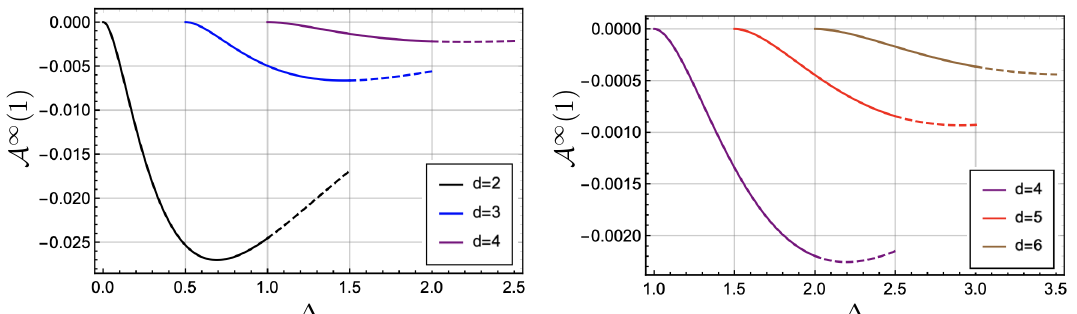
Figure 3. A ∞ ( U 0 ) = R ∞ T UU dU versus ∆ for increasing values of d . On the left panel we have d = U 0 2 (black curve), d = 3 (blue curve), d = 4 (purple curve). On the right panel we have d = 4 (purple curve), d = 5 (red curve), d = 6 (brown curve). The solid curves are plotted for d which is the range in which the deformation is relevant, while the dashed ones are plotted for d − 1 ≤ ∆ ≤ d +1 , which is the range in which (3.16) is valid. Here, we set U 0 = 1 2 2